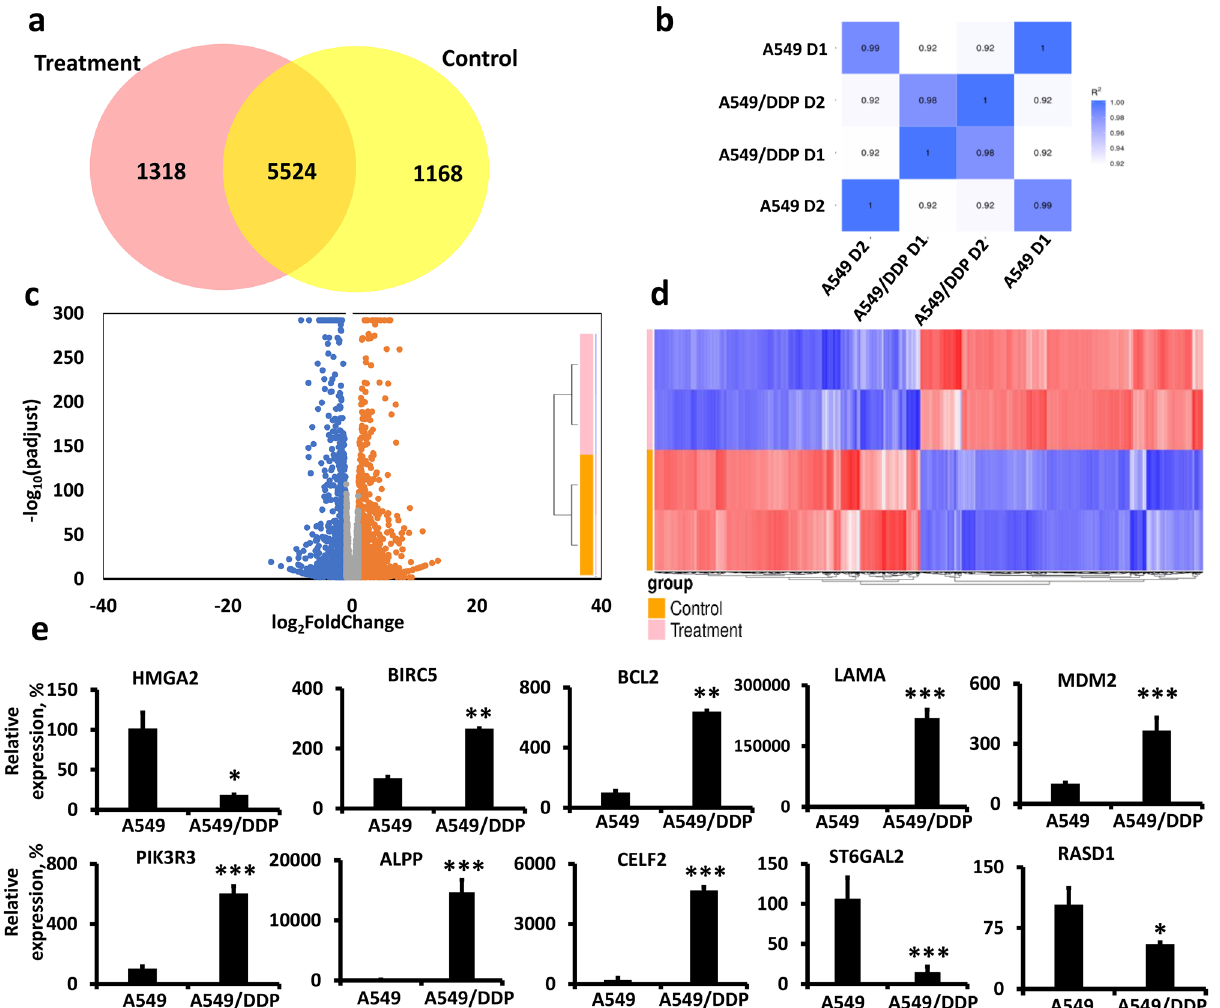
Figure 3. RNA-seq analysis of mRNA extracts from A549 and A549/DDP cells. ( a ) Venn diagram of upregulated genes in control (A549) or treatment (A549/DDP) cells with |Log 2 FC|> 1; ( b ) Pearson Correlation coefficient matrix between samples; ( c ) Volcano graph of gene dysregulations. Colored is for | Log 2 FC|> 1 and FDR < 0.05; ( d ) Heatmap of gene expression; ( e ) qPCR analysis of representative genes. * p < 0.05; ** p < 0.01; *** p < 0.001 for A549/DDP compared to A549.